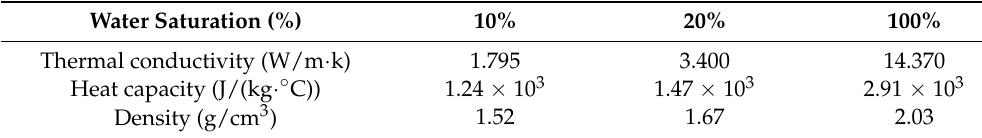
Table 2. Different water saturation model parameters.